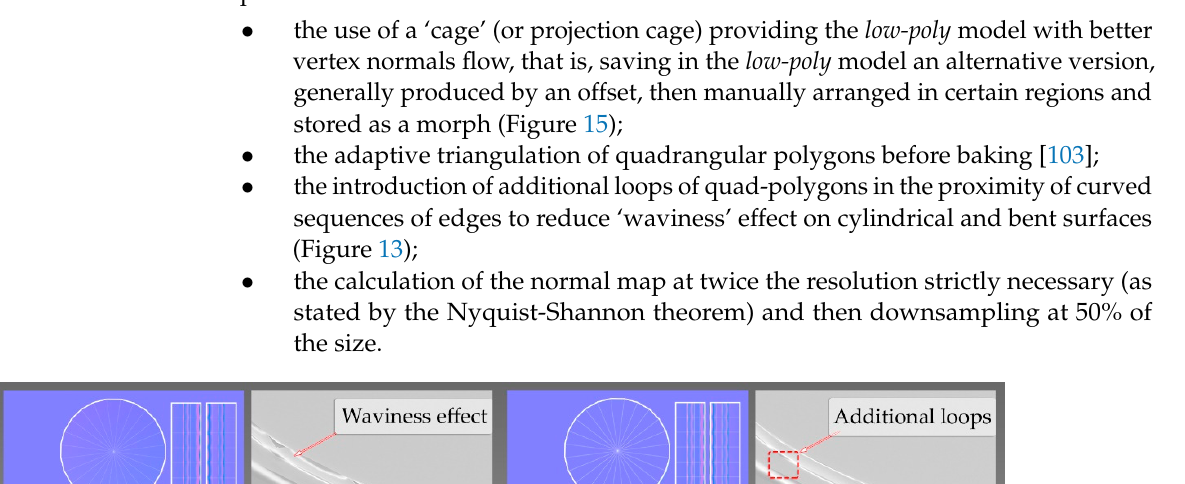
Figure 17. The automatic modelling steps (global remeshing and quad-remeshing).